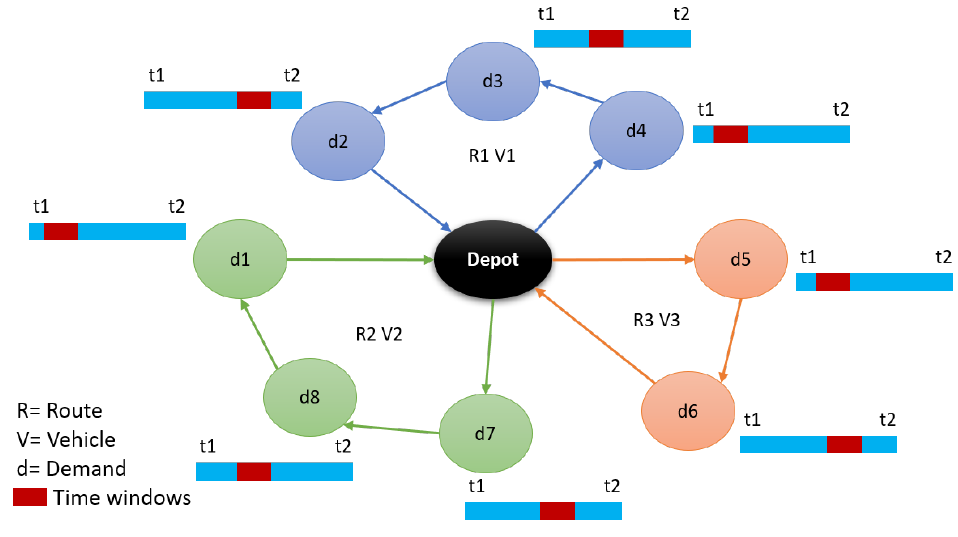
Figure 1. Illustration of a VRPTW